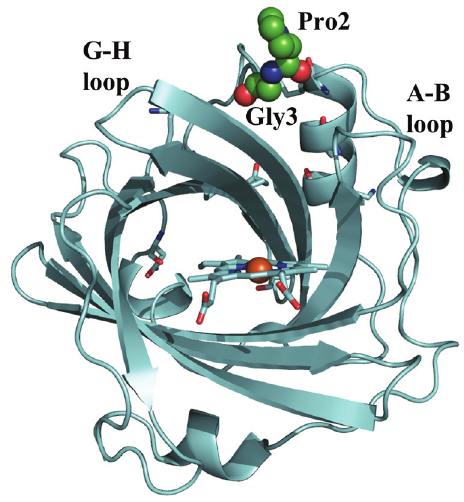
Figure S2. Representation of the backbone in the X-ray structure of NP7 solved at low pH (5.8). Residues Pro and Gly of the extra N-terminus stretch (Leu-Pro-Gly) found in NP7 are shown as green-coloured spheres. The spatial position of Leu, and the additional Met0 residue originating from the start codon of the expression system, were not seen in the X-ray